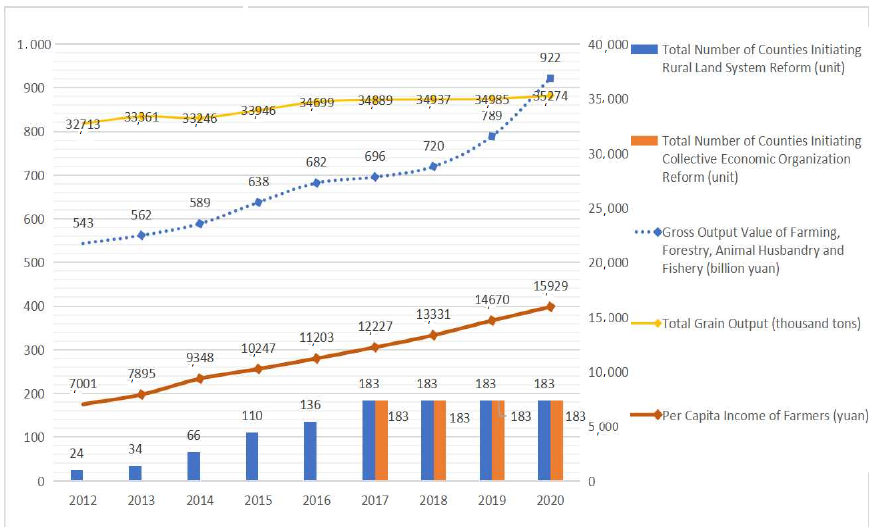
Figure 1. Rural reform and the trend of agricultural growth in Sichuan since 2012. Note: 1 . The number of counties initiating the rural land system reform, the number of counties initiating the collective economic organisation reform and the gross output value of farming, forestry, animal husbandry and fishery on the left axis. 2. Total grain output and per capita income of farmers on the right